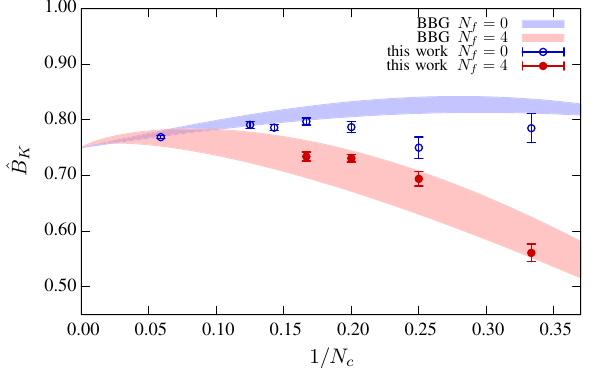
Fig. 4 Half-sum and half-difference of the amplitudes A ± as a func- tion of N − 1 c for three different cases: (i) quenched results from Ref. [6] in blue, (ii) new dynamical results at a pion similar to the quenched case